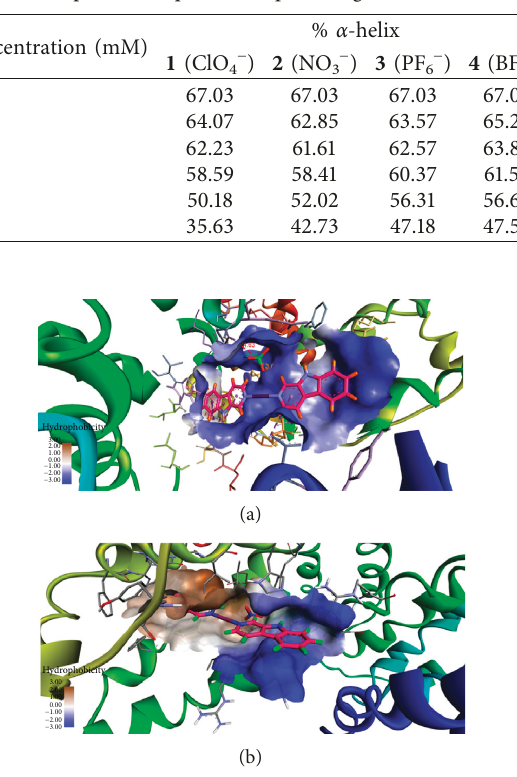
Figure 9: (a) Molecular docked model of compound 1 (stick representation) located within the hydrophobic pocket in the subdomain IIA of HSA; (b) molecular docked model of compound 2 (stick representation) located within the hydrophobic pocket in the subdomain IB of